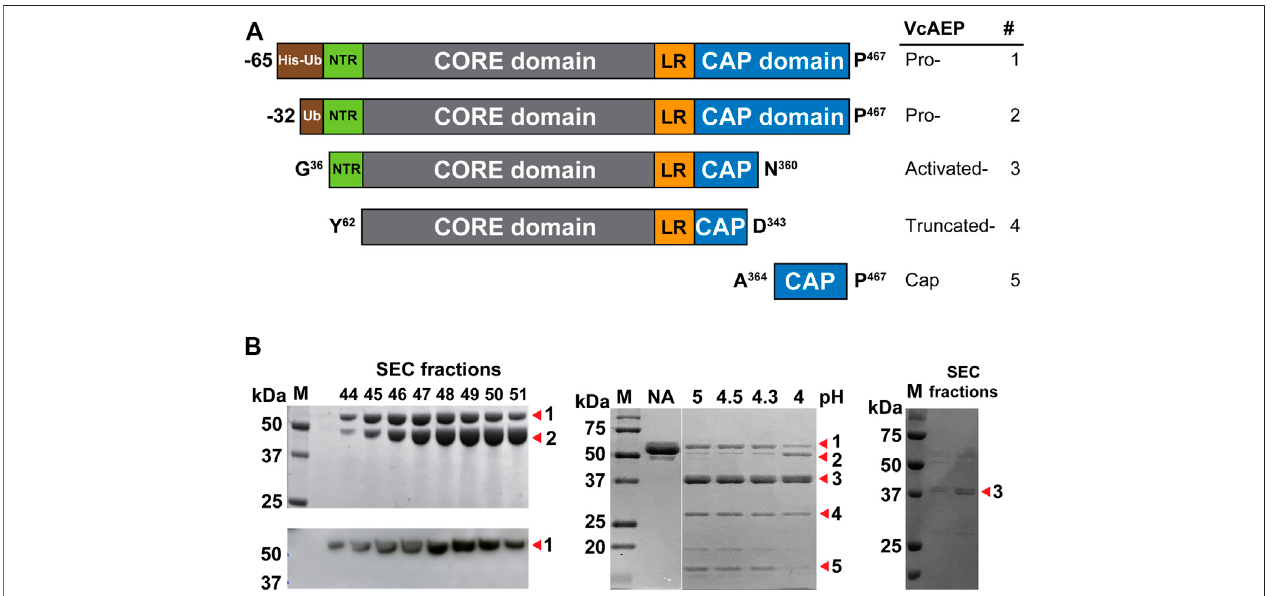
FIGURE 1 | Puri fi cation and activation of VcAEP. (A) Schematic representation of recombinant VcAEP constructs. Pro-VcAEP 1: full-length proenzyme form expressed withHis-Ub-VcAEP (His (cid:1) His6 tag, Ub (cid:1) ubiquitin)and ending at P467. Pro-VcAEP 2: full-length VcAEP without the His-tag.Activated-VcAEP 3: active form of VcAEP after acidic autoactivation that begins with G36 and ends with N360. Truncated-VcAEP 4: truncated form of VcAEP, starting with Y62 and ending with D343. Cap 5: cleaved cap domain after acidic autoactivation, starting with A364 and ending with P467. The processing sites were determined by in-gel trypsin digestion followed by MS/MS de novo sequencing. NTR, N-terminal region; LR, linker region. (B) Puri fi cation, expression and activation of VcAEP. Left panel: analysis of puri fi ed fractionsobtainedfromSECchromatography,SDS-PAGE(upper)andwesternblot(lower).SDS-PAGEshowstwobands,Pro-VcAEP1andPro-VcAEP2(seepanelA), with the lower band 2 being the VcAEP proenzyme without the His tag. Middle panel: SDS-PAGE analysis ofthe lauroylsarcosine-mediated acidic autoactivation of Pre- VcAEP 1and Pro-VcAEP 2and its products Activated-VcAEP3, Truncated-VcAEP4, and Cap5, performed at pH 4 – 5 at 37 ° Cfor 30 min togenerate Activated-VcAEP 3 ( ∼ 37 kDa). NA: no activation. Right panel: SDS-PAGE analysis of puri fi ed Activated-VcAEP 3 by SEC chromatography using pH 4